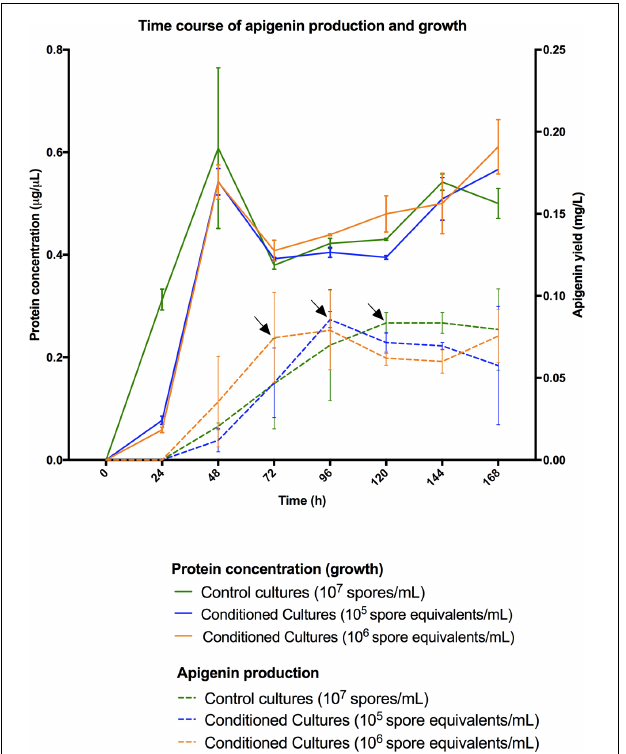
FIGURE 4 | Streptomyces albus -pAPI growth curves (solid lines) and apigenin production curves (dashed lines) for three different types of cultivation experiments (mean values from three independent triplicate flasks). Green colors correspond to control cultures with 10 7 spores/mL. Blue colors correspond to conditioned cultures with a preinoculum of 10 5 spore equivalents/mL. Orange colors correspond to conditioned cultures with a preinoculum of 10 6 spore equivalents/mL. Apigenin production is anticipated in conditioned cultures, even with a delayed growth during the first 24-h, and achieving same production levels 1 and 2 days in advance, respectively. Maximum production levels for apigenin titers are labeled by arrows.